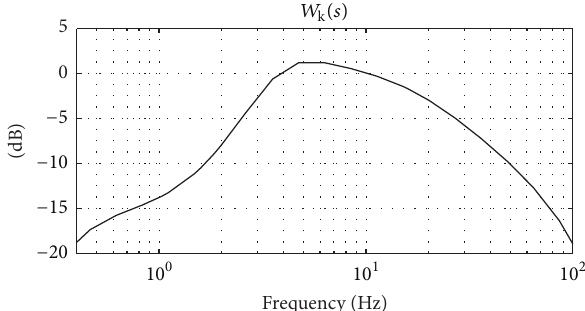
Figure 5: ISO2631 frequency weighting